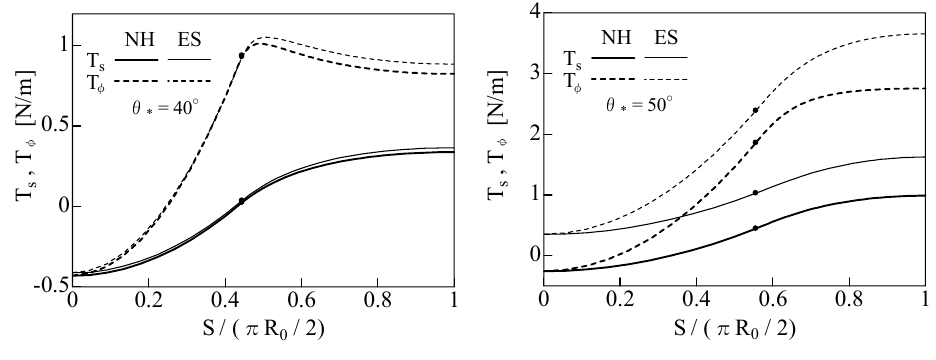
Fig.8 Distributions of the tensile stress